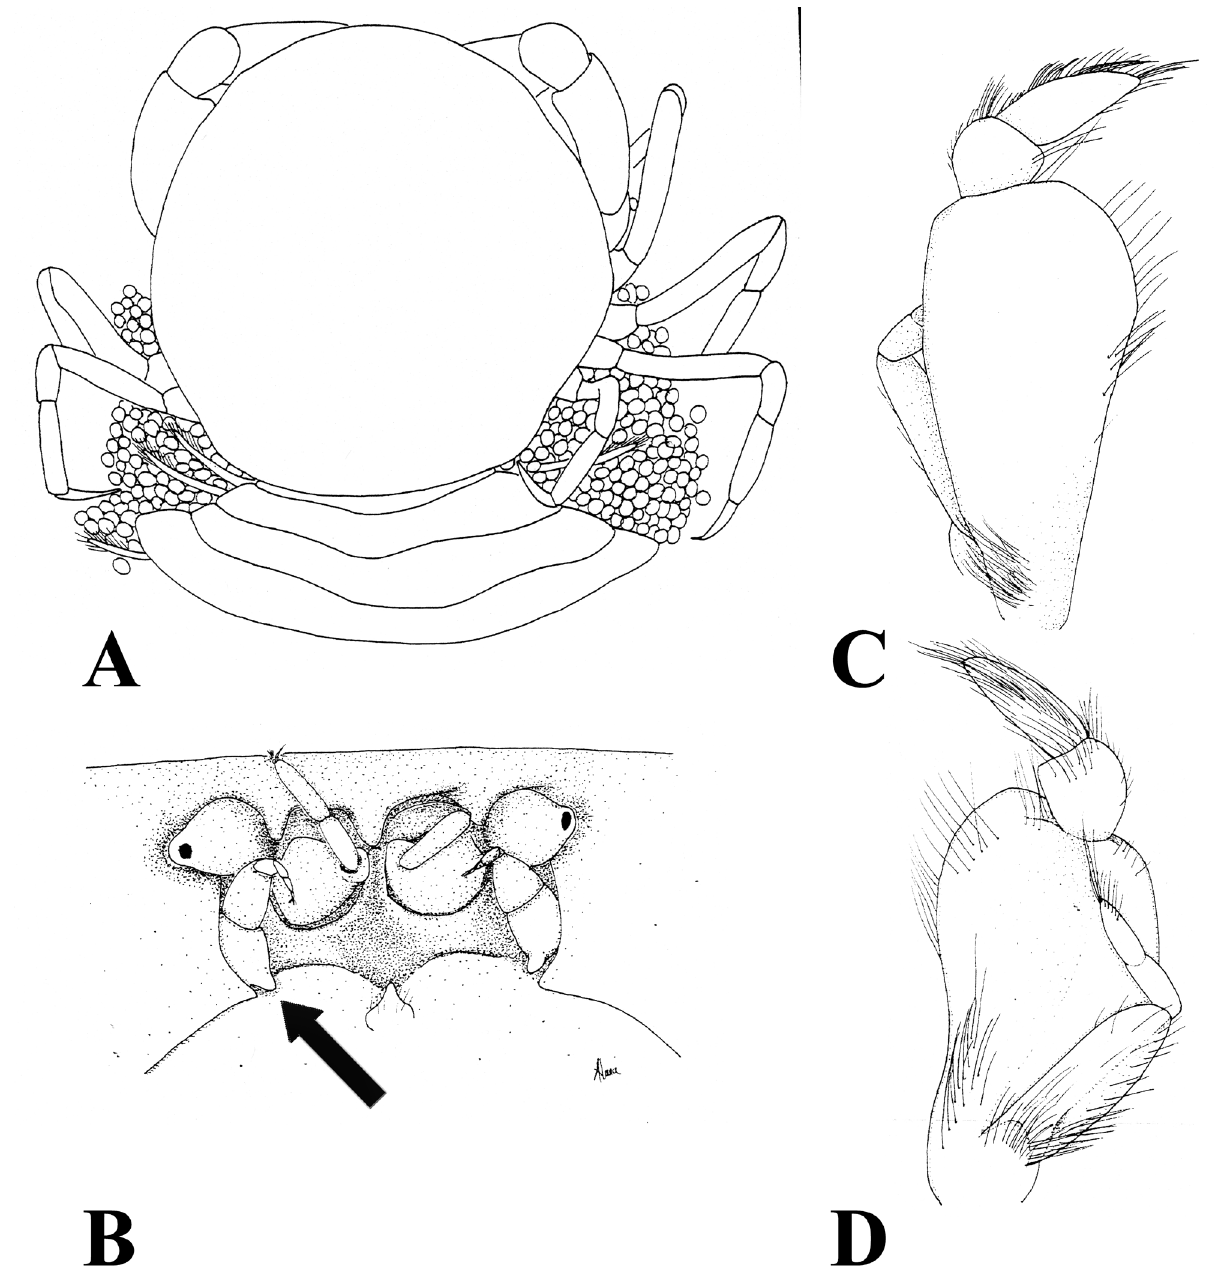
Figure 1. Gemmotheres chamae (Roberts, 1975). Ovigerous female. A, dorsal view; B, frontal view; C, D, maxilliped 3, inner and outer face respectively. Arrow indicates a subconical protuberance on article 1 of antennae which has the nephridiopore of the antenna 1 gland (= green gland). Carapace width 5 mm, paratype, USNM 139099 off North Carolina, U.S.A. (after Campos,